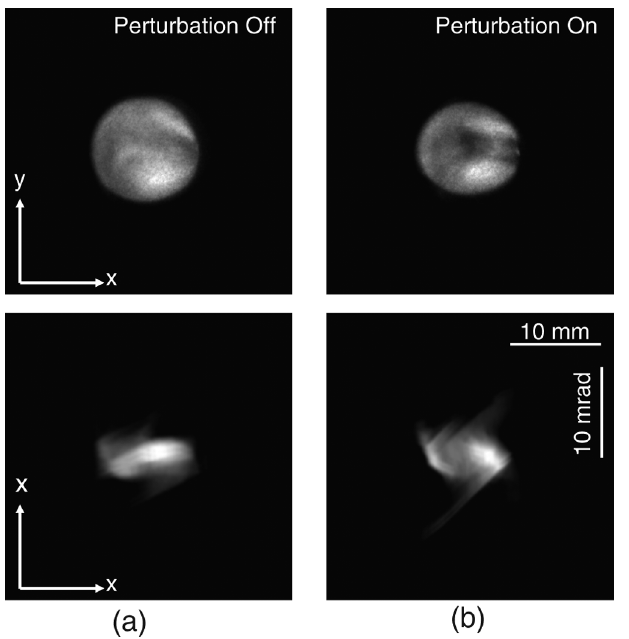
FIG. 5. Beam configuration space (top) and measured x - x 0 phase space by tomography (bottom) reconstructed at the screen location: (a) Without, and (b) with the perturbation. The sub- tracted phase-space slopes, (cid:6) , are 7 : 4 mrad = mm in both cases. Images are obtained within a 100 ns gate encompassing the entire